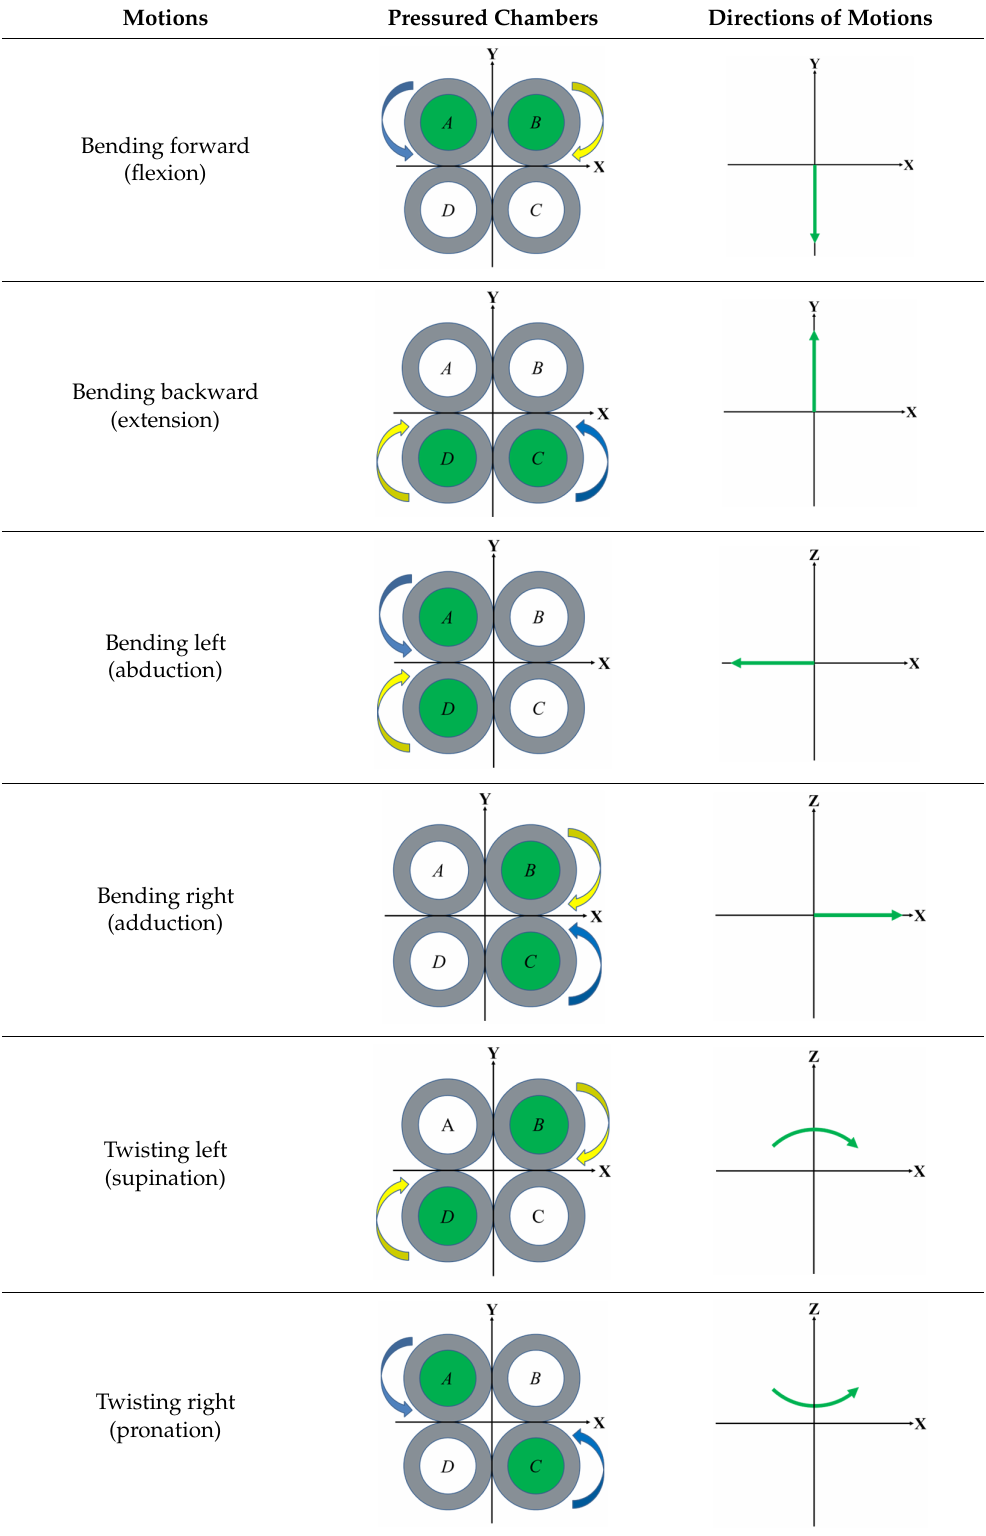
Table 1. Soft wrist motions corresponding to pressurization of different